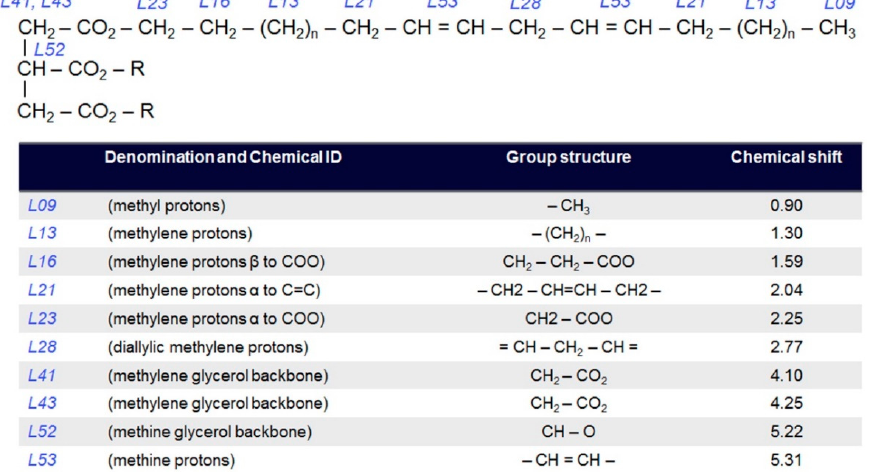
Table 1. Fat peaks (concentrations in millimoles) obtained for all voxels, normal fibroglandular tissue (FGT) and tumors. p -values refer to the comparison of fat peaks between normal FGT and tumors. Characteristic